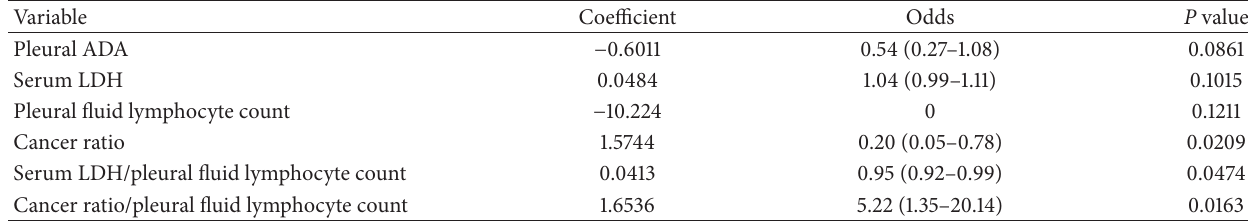
Table 2: Logistic regression analysis for prediction of malignancy.